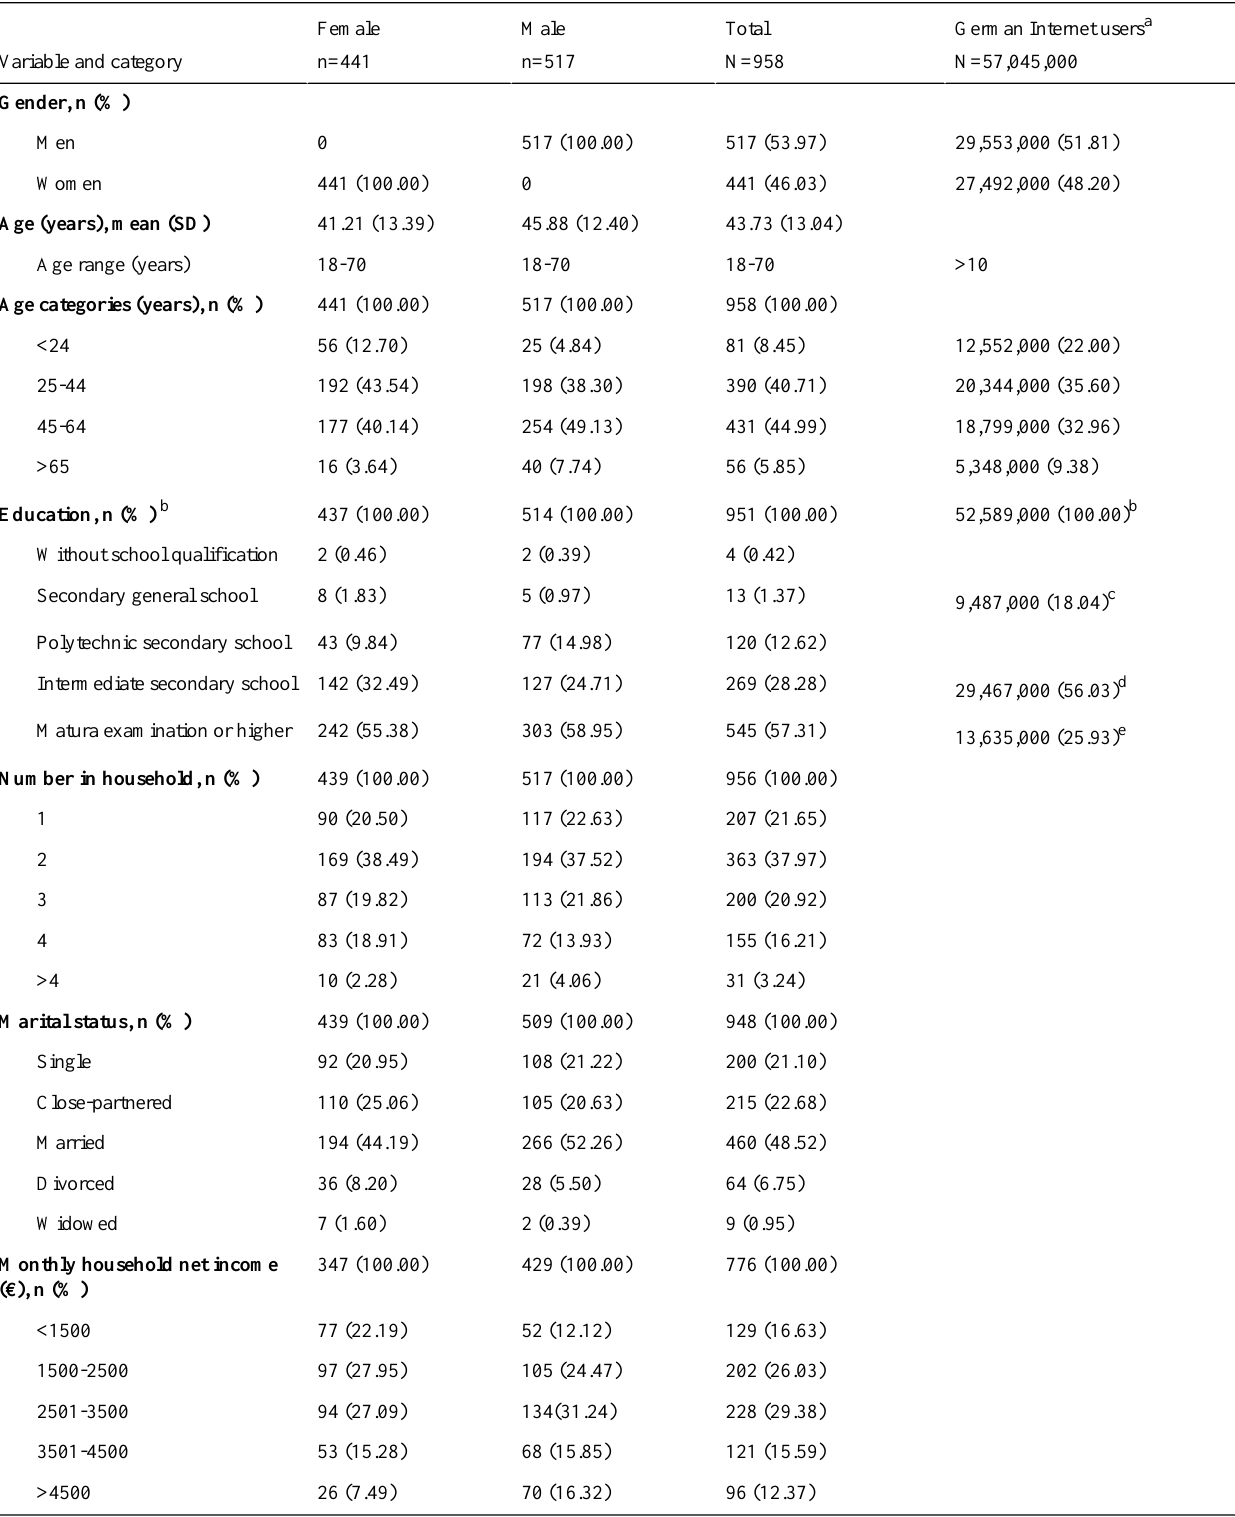
Table 1. Characteristics of study sample compared to the German Internet population in